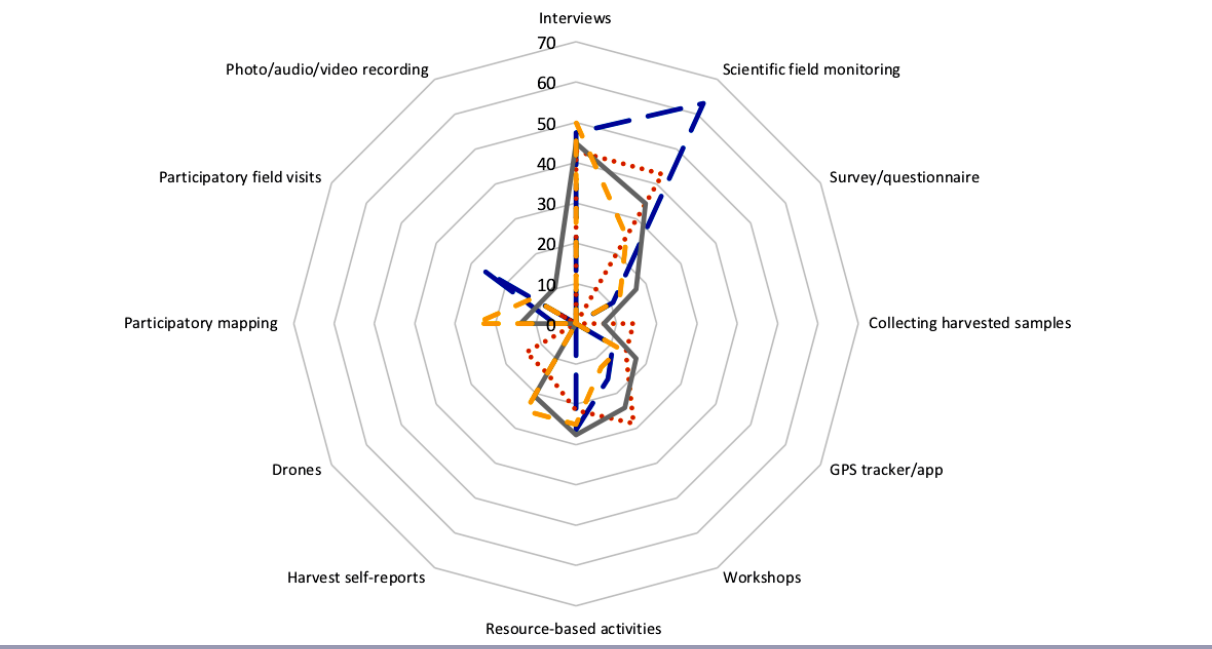
Fig. 6 . Percentage of monitoring initiatives at each level of Indigenous participation, displayed according to monitoring methods. Initiatives are classified according to the degree of participation of Indigenous people: the blue dashed line indicates externally driven initiatives with Indigenous people as data collectors (IP1); the orange dotted line indicates collaborative initiatives with Indigenous people playing some role in design and execution (IP2); the grey solid line indicates collaborative initiatives with Indigenous people playing a strong role in design, execution, and management (IP3); and the yellow dashed line indicates autonomous monitoring by Indigenous people with some external support